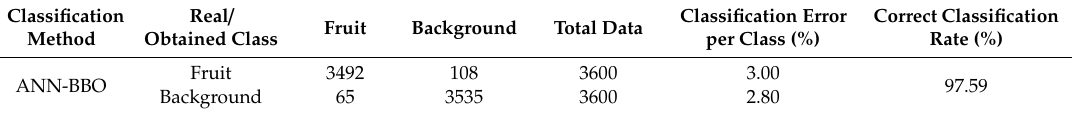
Table 6. Confusion matrices, classification error per class, and correct classification rate (CCR) in the best state of training of the hybrid ANN-BBO classifier for the testing data.